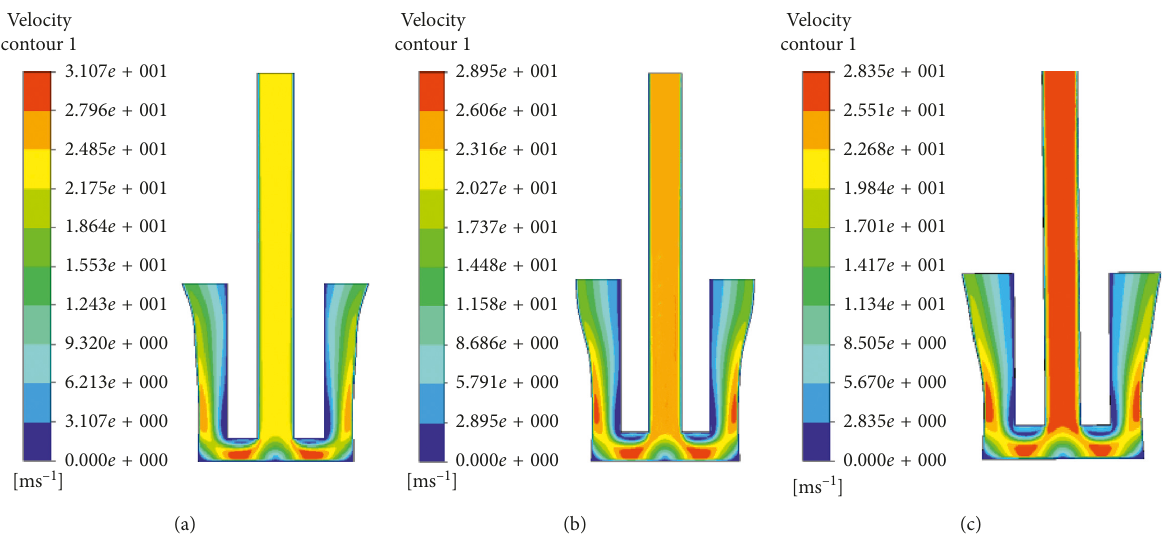
Figure 15: Electrolyte flow velocity distribution under different electrolyte concentrations. (a) U � 9 V ξ � 7% (wt.%). (b) U � 9V ξ � 11% (wt.%). (c) U � 9V ξ � 15% (wt.%).